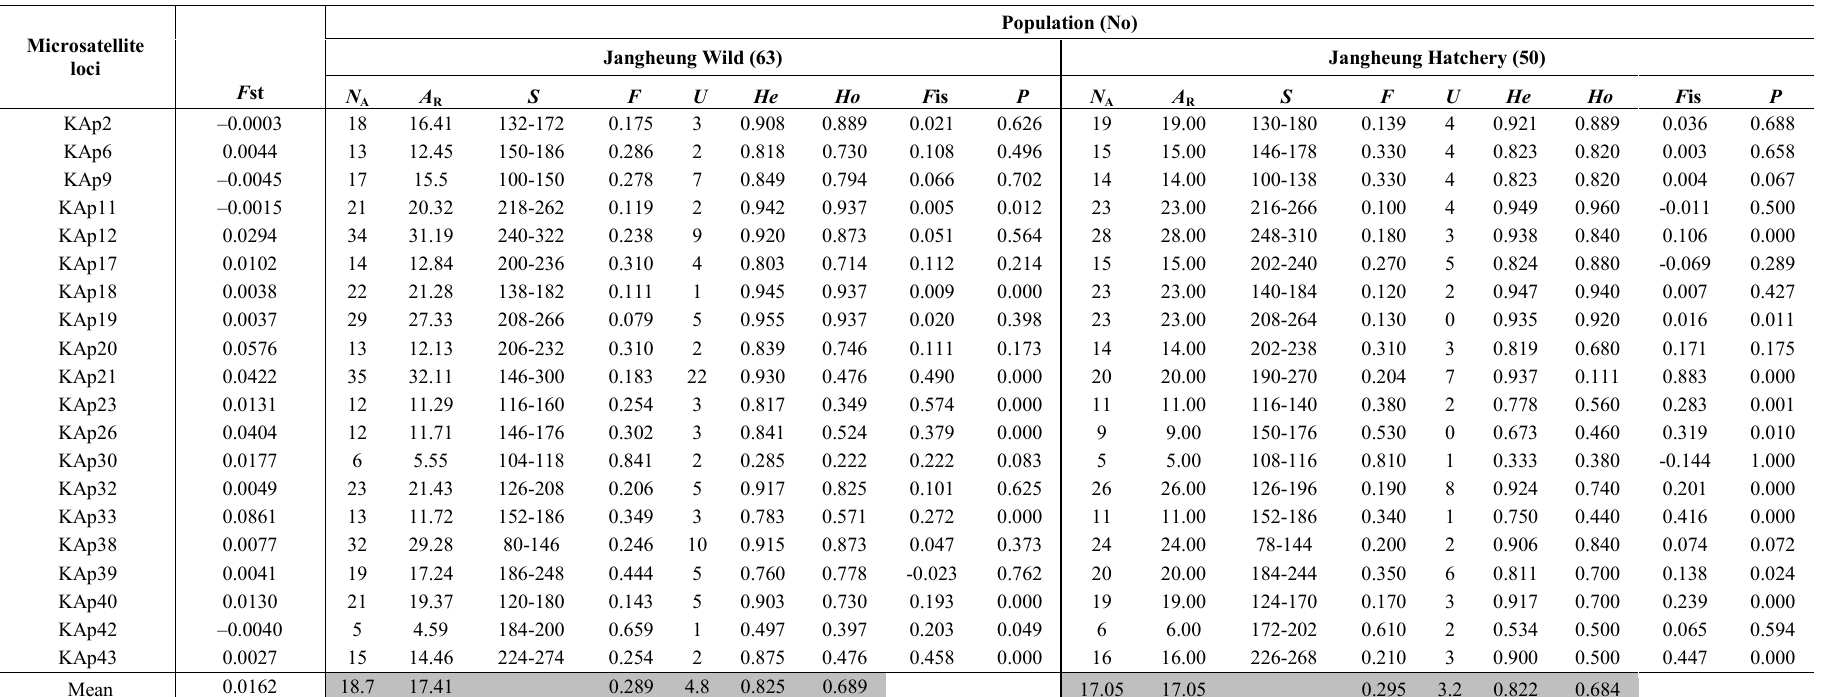
Table 2. Summary of the statistics for 20 microsatellite loci in the two Atrina pectinata populations. Microsatellite